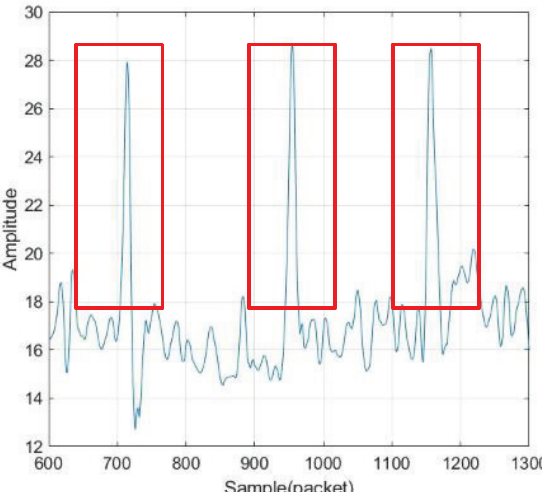
Figure 4. Segment the